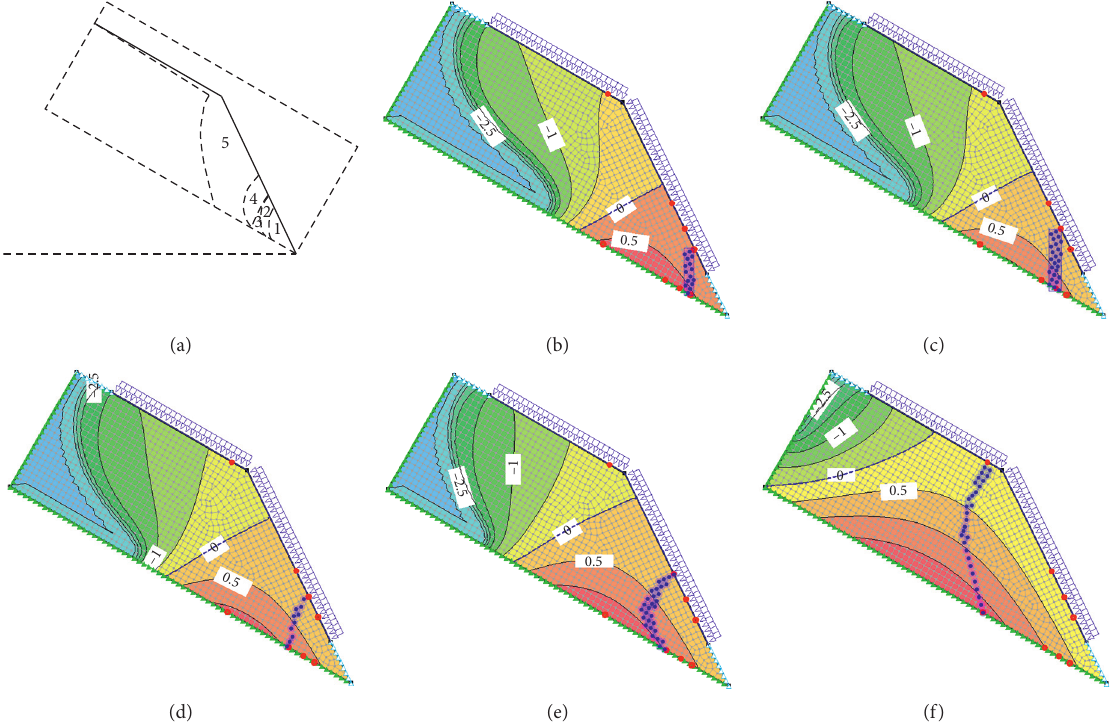
Figure 10: Slip surface shapes (a) and measuring points (blue dots) of pore-water pressure that constitute the slip surface of the (b)